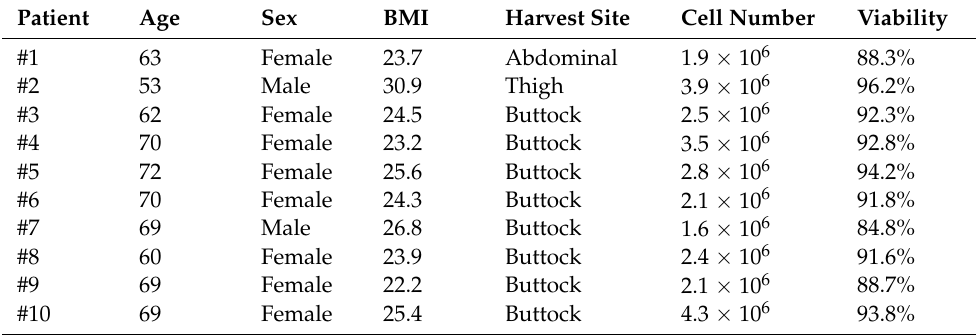
Table 1. Patient information. Cells from patients #1 to #6 were used for in vivo experiments, and cells from patients #7 to #10 were used for in vitro experiments.